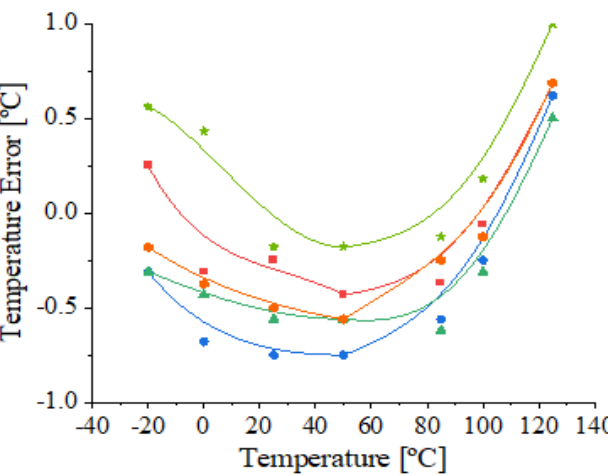
Figure 8. Measured temperature error of 5 trimmed DTS samples at 1.8 V.